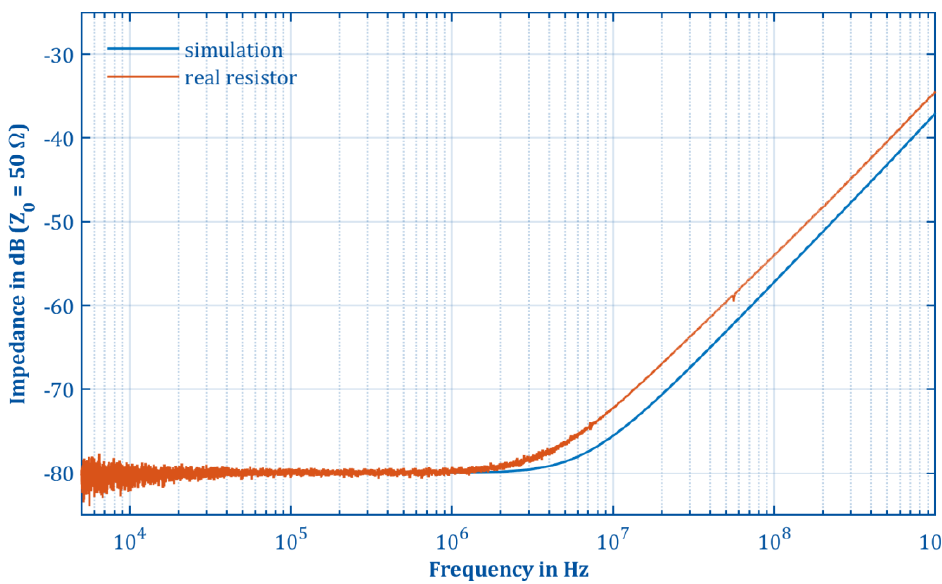
Figure 9. Comparison of the simulated and measured transmission response parameter S 21 of a SMD resistor 1 MΩ Vishay PTN1206E1004BBT1.